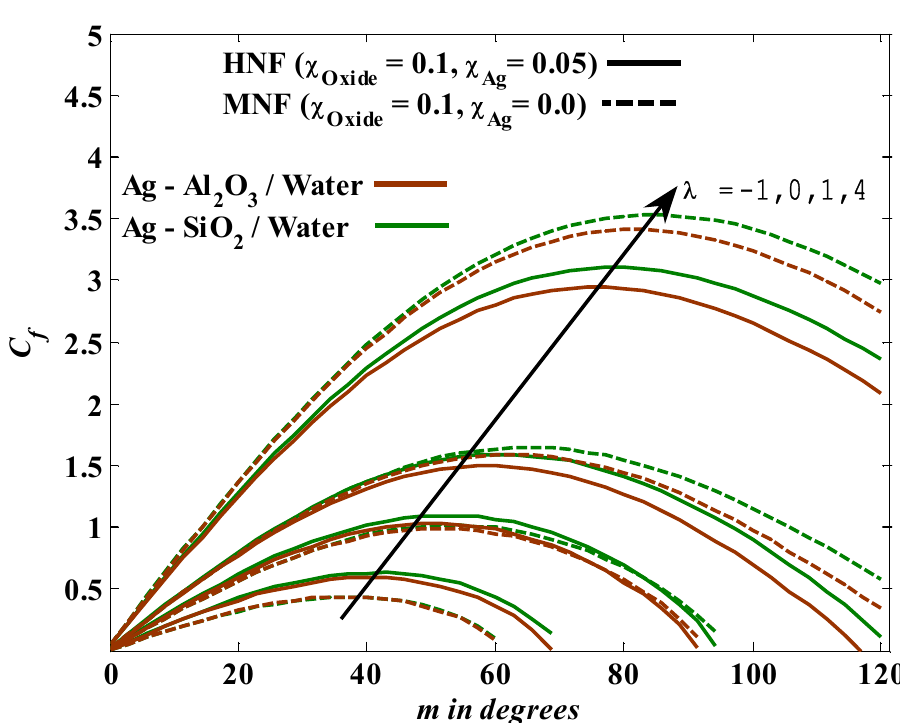
Figure 7. Illustration of λ versus skin friction at fixed values of We = 0.2, R = 0.1, & M = 1.